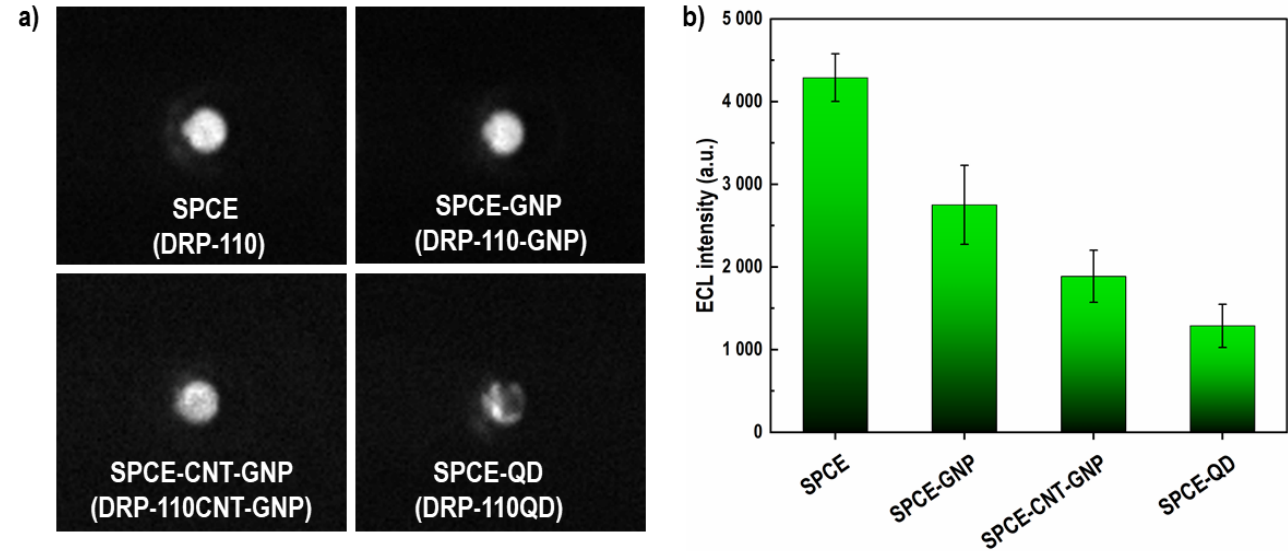
Figure 2. ( a ) Representation of ECL images obtained from four different commercial screen-printed electrodes (SPEs) using Vilber Fusion FX6 EDGE (Vilber Smart Imaging) (MSD Free Tag solution 15,000 a.u., 100 µL, LSV 200 mV/s, 0.1–1.8 V); ( b ) ECL intensity (n = 3) calculated by integration of light spot using ImageJ software, errors bars correspond to STDEV. Electrodes tested: SPCE (DRP-110), SPCE-GNP (DRP-110-GNP), SPCE-CNT-GNP (DRP-110CNT-GNP), and SPCE-QD (DRP-110QD).